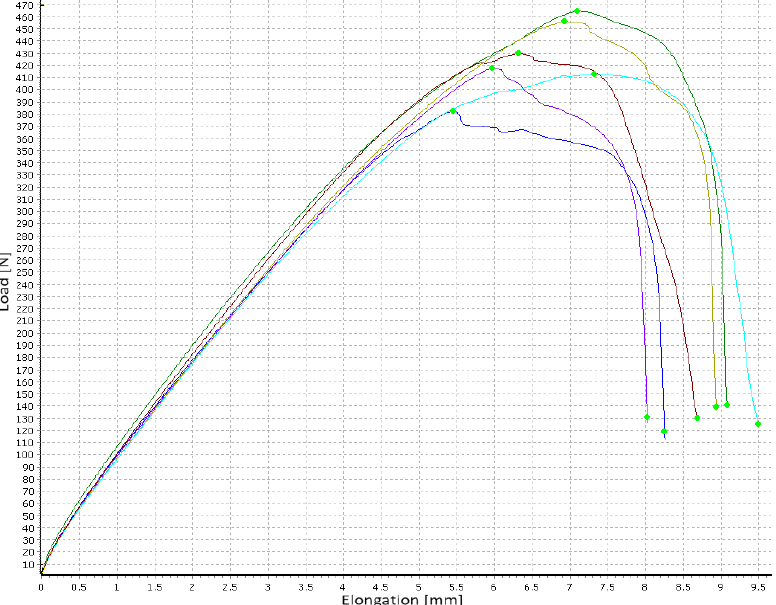
Figure 4. Example of shear test results for measuring adhesive deformation on galvanised strips.